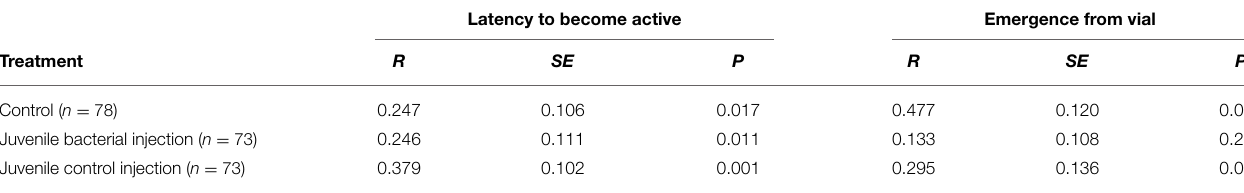
Values were calculated individually for each treatment